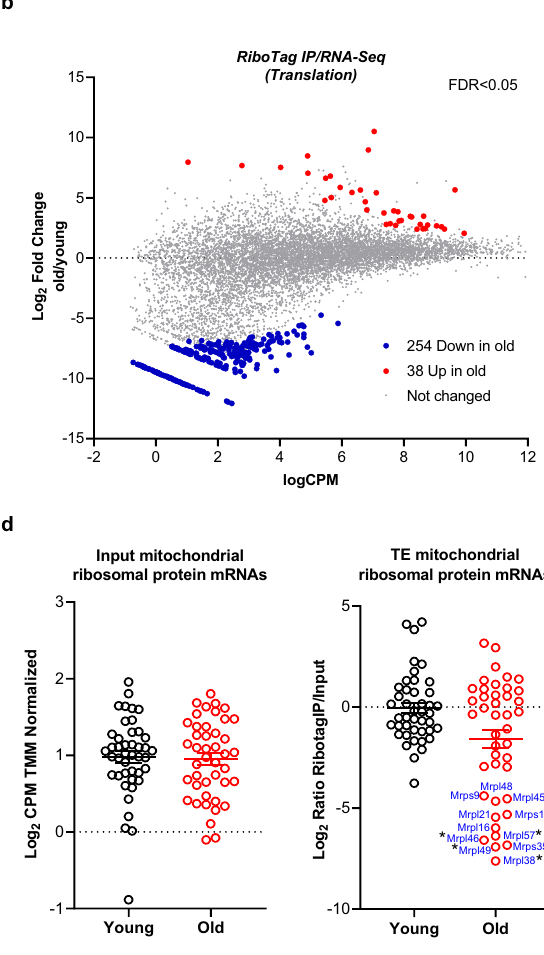
Fig. 1 | Differences in transcriptome and translatome in young and old MII oocytes. MII oocyteswerecollected fromyoungandold RiboTag F/F ;Zp3-Cre mice and RiboTag IP followed by RNA-Seq was performed as described in “ Methods ” . Two biological independent samples are used. a , b MA-plot of gene expression changes for total transcripts ( a ) and ribosome loading on transcripts ( b ) are reported. The log 2 fold changes for young vs old oocytes is plotted on the y axis and the log 10 of the average counts per million reads (CPM) is shown on the x axis. Each gene is represented by a dot. Genes with FDR<0.05 are shown in red (upregulated) or blue (downregulated). c Gene ontology analysis of mRNAs